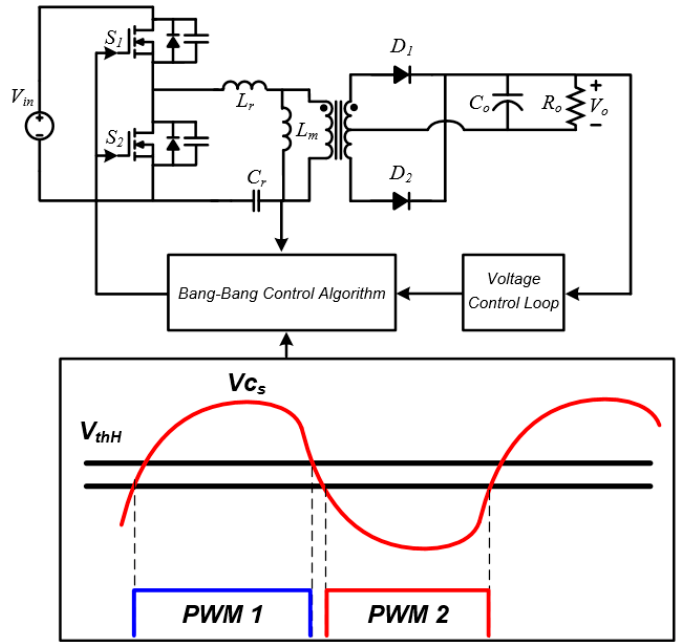
Figure 15. Bang-bang charge control algorithm in [46].